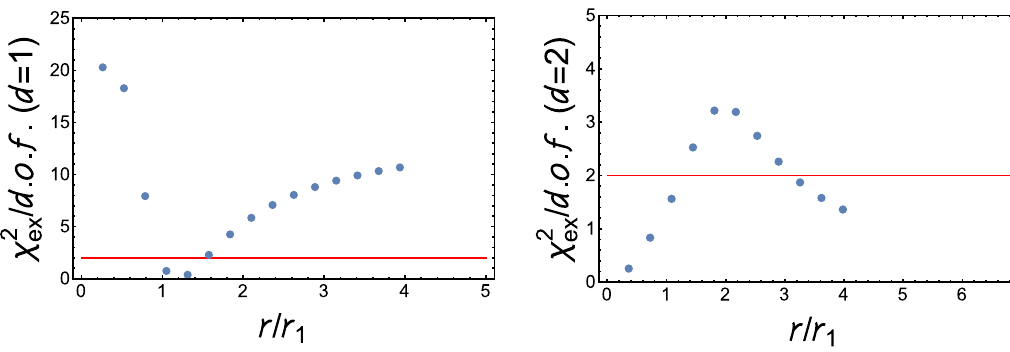
Figure 16 . The reduced (cid:31) 2